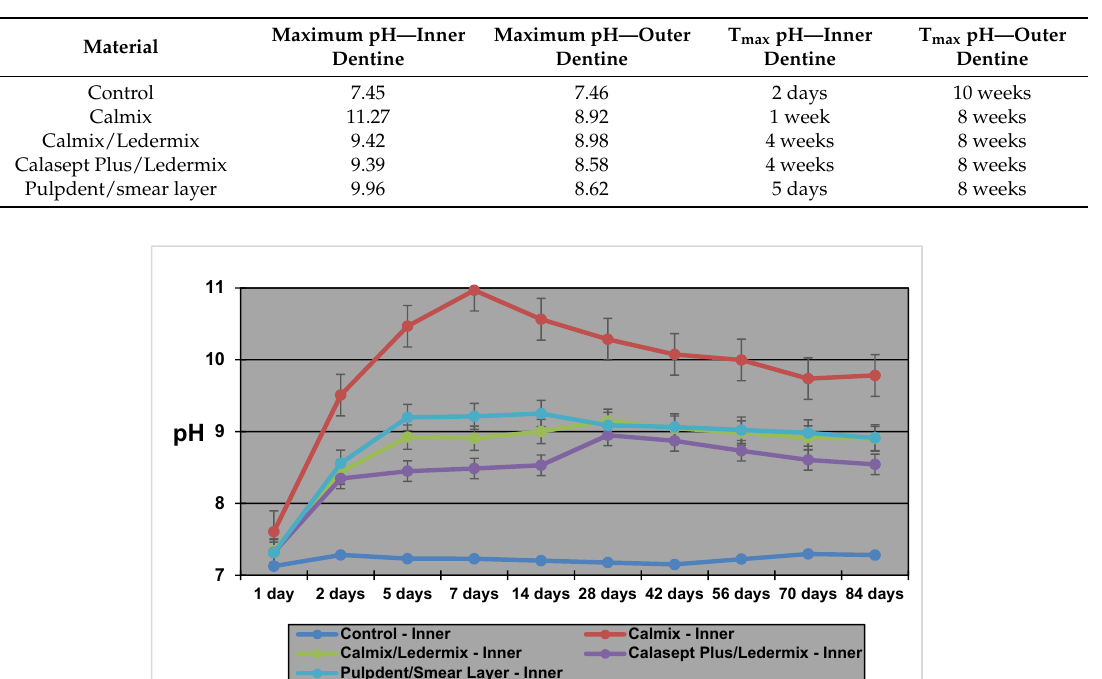
Table 1. Maximum pH values obtained and the time taken to reach maximum pH (T max ) in the different levels of dentine.